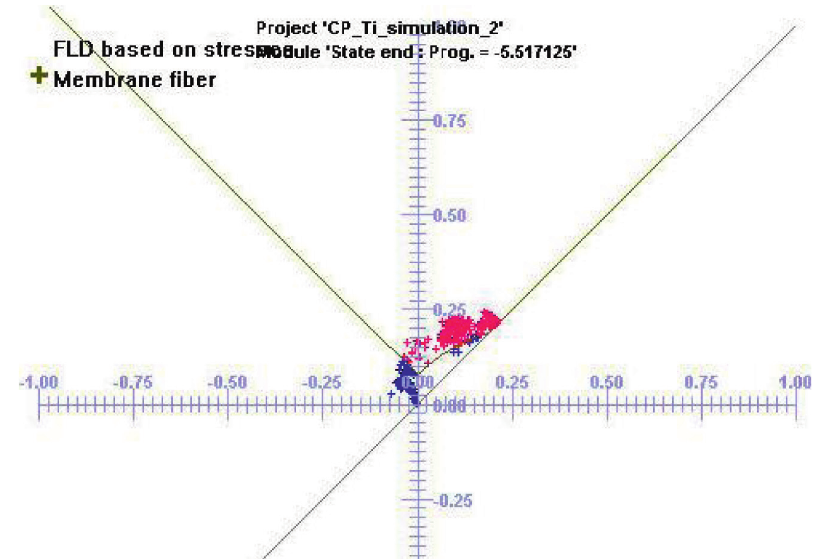
Equivalent stress -Membrane 0.206448 0.177363 0.148277 0.119192 0.090106 0.061021 0.031935